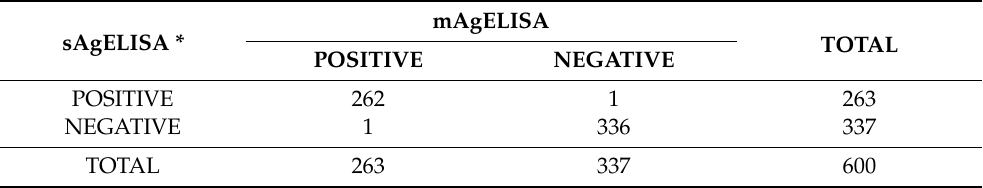
Table 3. Comparison between results of the sAgELISAs and the mAgELISA for detection of antibodies to bovine and bubaline alphaherpesviruses in bovine sera (n = 600) **.